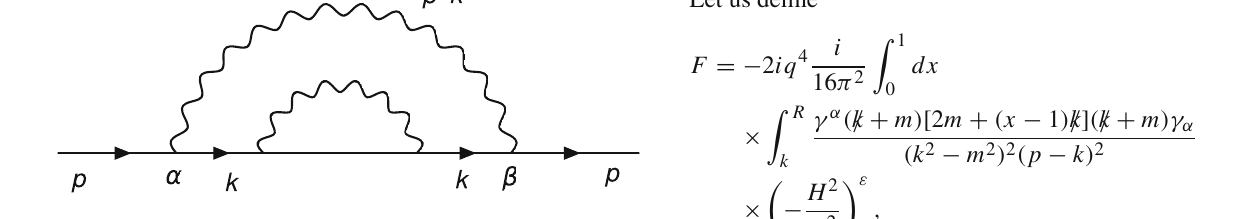
Fig. 3 Diagrammatic representation of the nested contribution to the electron self-energy at two-loop order. The wavy and solid lines repre- sent the photon and fermion propagators,